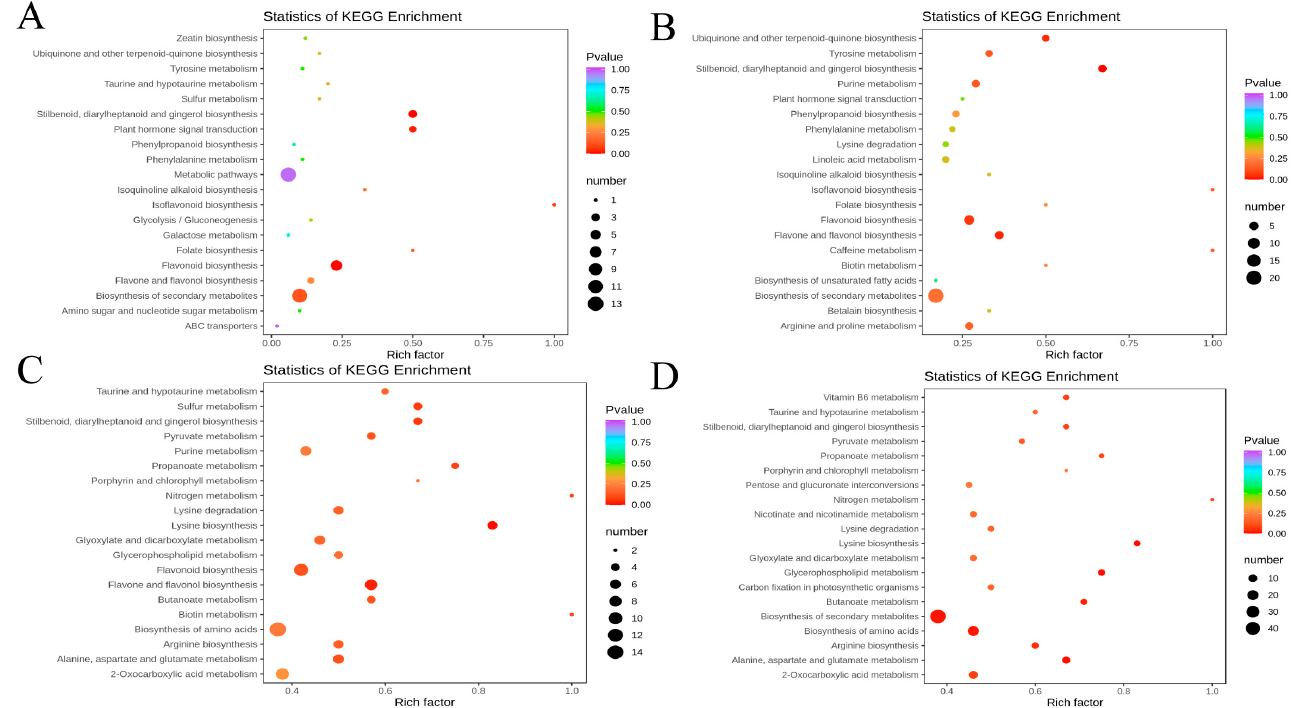
Figure 4. KEGG annotations and enrichment of differentially expressed metabolites of each pairwise comparison of grape berries. ( A ) GP6-He vs GP6-In; ( B ) Mar-He vs Mar-In; ( C ) Mar-He vs GP6-He; ( D ) Mar-In vs GP6-In.